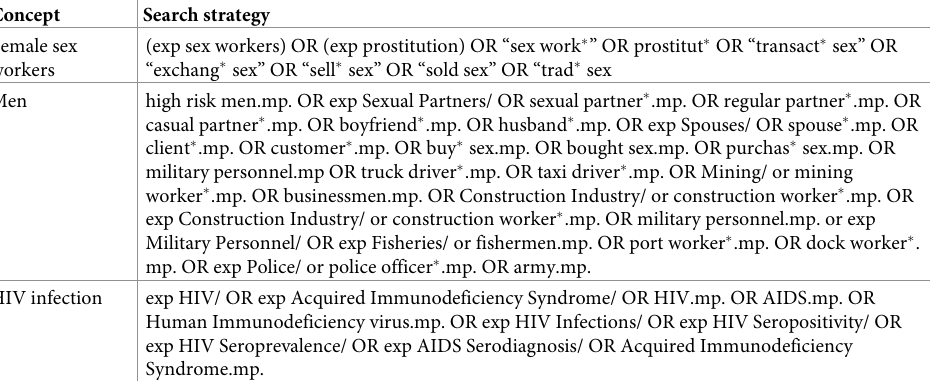
Table 1. Literature search